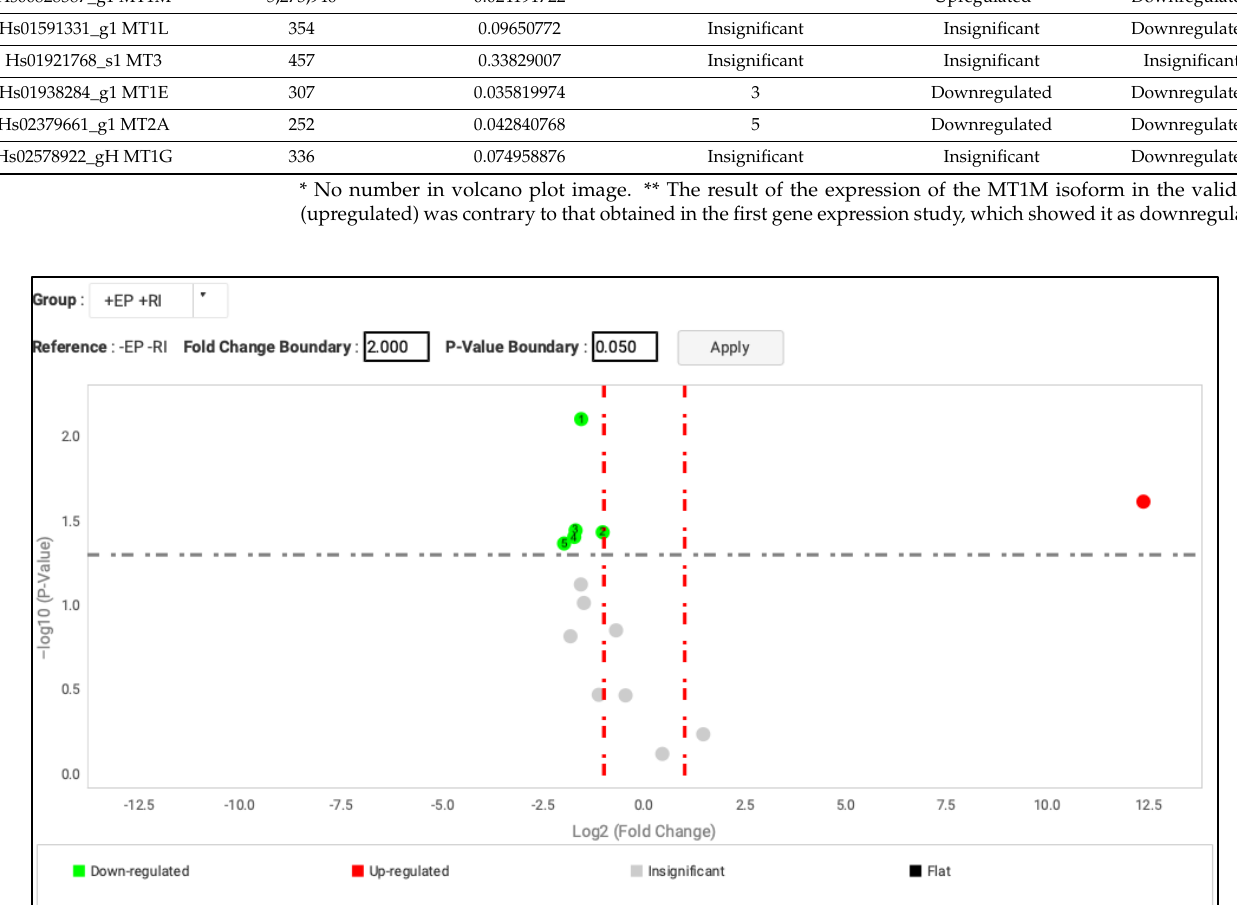
Figure 2. Volcano plot thermo image. Comparison of the results PD+RI − VS PD − RI − (statistical anal- ysis using the t -test; fold change boundary: 2.000; p -value boundary: 0.05). All the isotherms studied, MT1F (FD 1.036; p = 0.9495), MT1X (FD 1.103; p = 0.8305), MT1E (FD 2.421; p = 0.36544), and MT2A (FD 0.762; p = 0.6600), MT1B (FD 3.549; p = 0.5021), MT1H (FD 2.945; p = 0.4616), MT1L (FD 1.100; p = 0.8783), and MT1G (FD 2.380; p = 0.3633) showed statistically significant results. PD = EP (Spanish acronyms for periodontal disease).